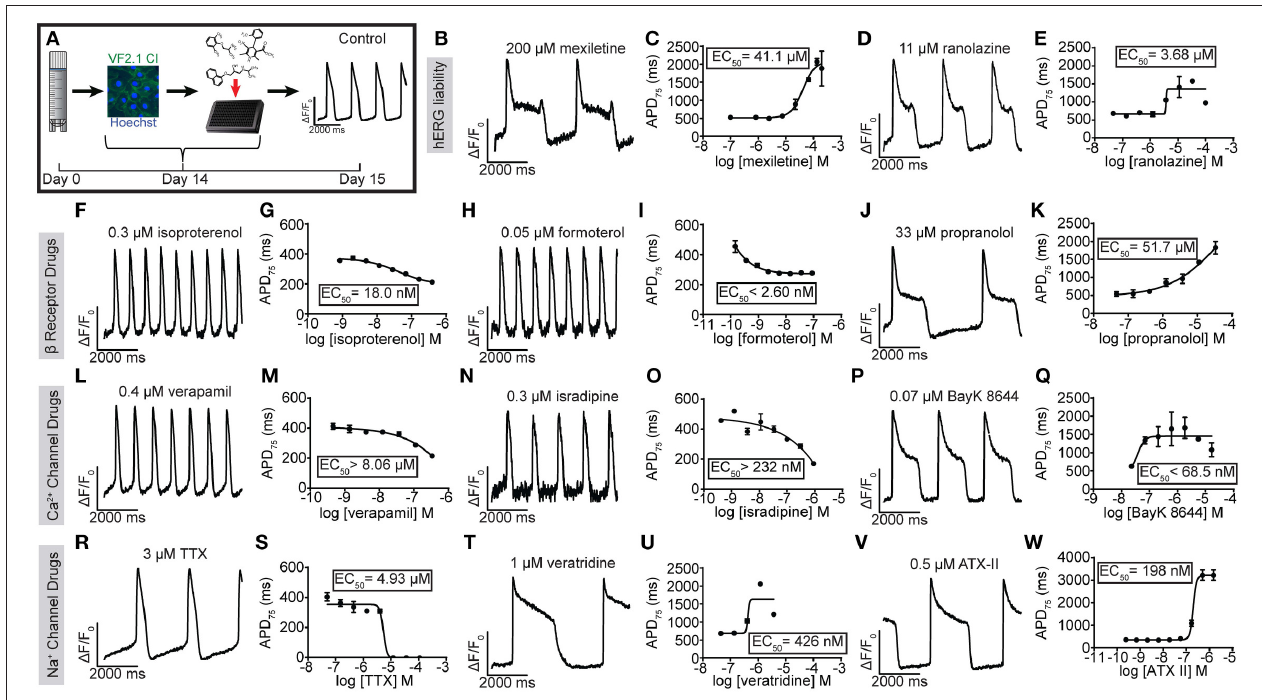
FIGURE 2 | Utility of VF2.1.Cl in measuring the effect of reference compounds on hiPSC-CM AP kinetics. (A) Schematic of treatment of normal individual (iCell) hiPSC-CMs with reference compounds and a 1 F/F 0 vs. time plot of an untreated well. (F–W) Representative normalized 1 F/F 0 vs. time plot (100Hz) and dose response curve for APD 75 for mexiletine (B,C) , ranolazine (D,E) isoproterenol (F,G), formoterol (H,I) , propranolol (J,K) , verapamil (L,M) , isradipine (N,O) , BayK 8644 (P,Q) , TTX (R,S) , veratridine (T,U), and ATX-II (V,W) in hiPSC-CMs. Each point represents an individual well, n = 3. Error bars are s.e.m. Scale bars indicate time (2,000 ms) and 1 F/F 0 (50% of the maximal obtained in each